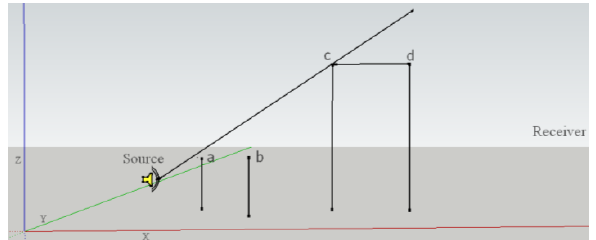
Figure 4. Determination of successive diffracting points. Here a, b, c, d are potential diffracting points of which c is the highest. The line connecting source to highest diffracting point is not obstructed by any other vertical edge hence c becomes the first diffracting point